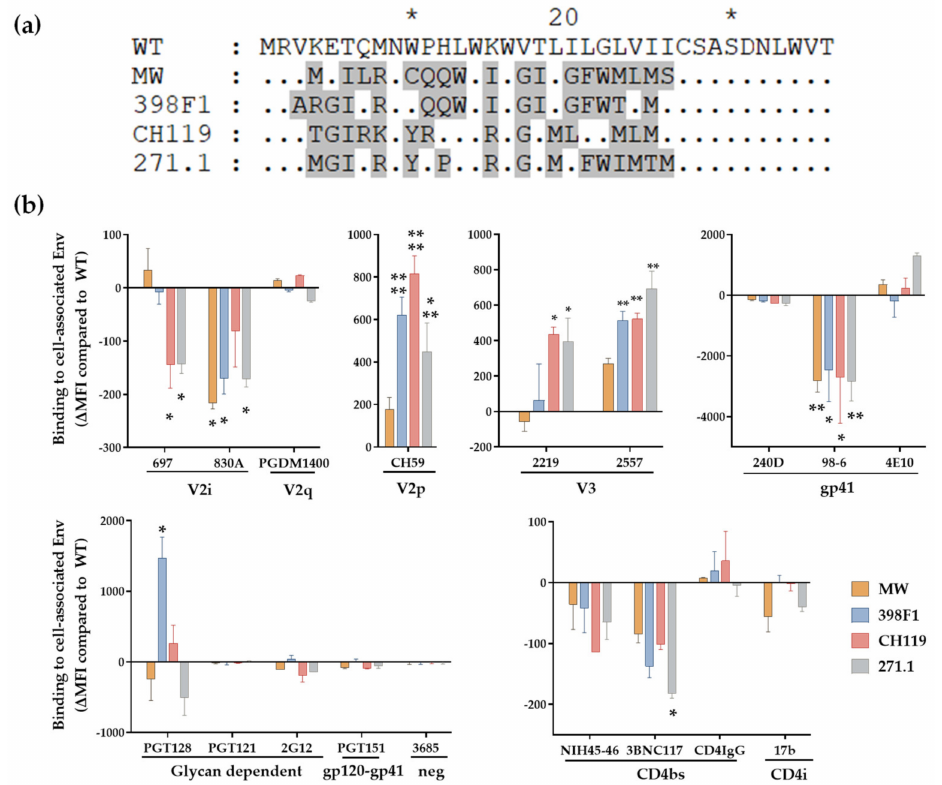
Figure 6. Effect of SP swap on CMU06 Env-antibody interaction. ( a ) Alignment showing the differences in SP sequences used to express CMU06 Env. SP sequences different from CMU06 native WT SP are shaded in gray and the similarities between the SP are indicated by dot, * denote blocks of 10. ( b ) Binding of mAbs to WT vs. SP-swapped Envs expressed on the surface of HEK293T cells. The mAbs were tested at following concentrations: 697, 830, and 3685 at 100 µ g/mL; 2G12 at 50 µ g/mL; PGDM1400, 2219, 2557, 240D, 98-6 and PGT121 at 25 µ g/mL; 4E10, 17b at 10 µ g/mL; PGT128, PGT151, 3BNC117 and CD4-IgG at 5 µ g/mL; CH59 and NIH45-46 at 2.5 µ g/mL. Normalized geometric mean fluorescence intensity (MFI) compared to WT (set as 100%) and SD from duplicates in one experiment are shown. MFI of negative control mAb were subtracted. Data were analyzed